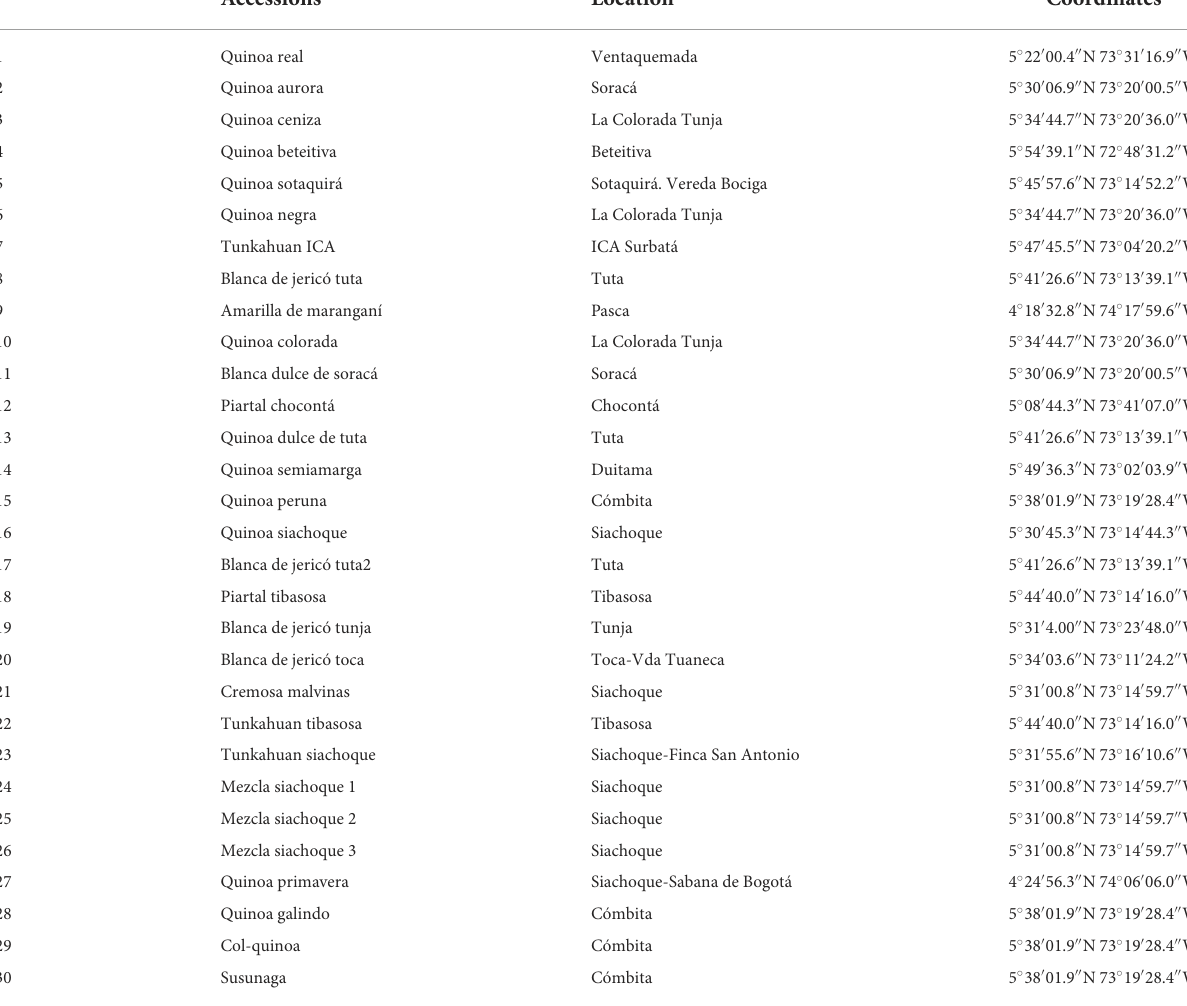
TABLE 1 Sites of origin of the evaluated quinoa ( C. quinoa ) accessions. Accessions Location Coordinates